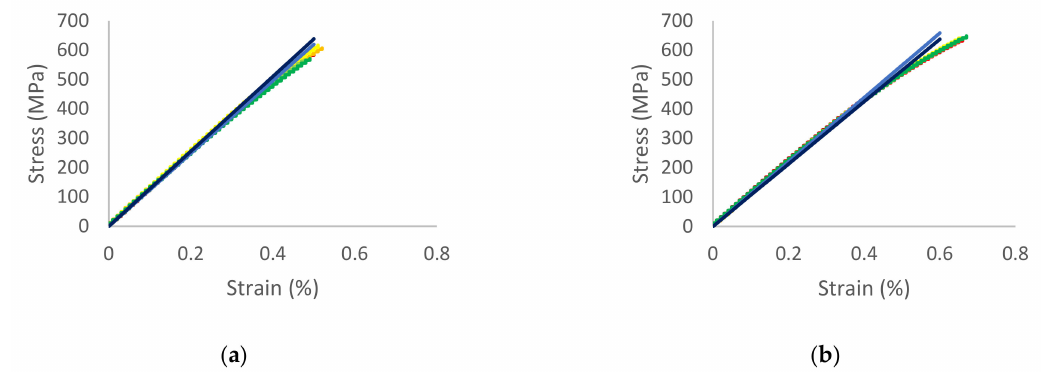
Figure 16. Stress–strain curve for elliptical pores. ( a ) Type II. ( b ) Type III.